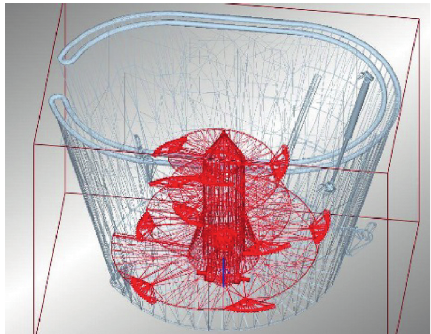
Figure 8: Simulation model of the mixing